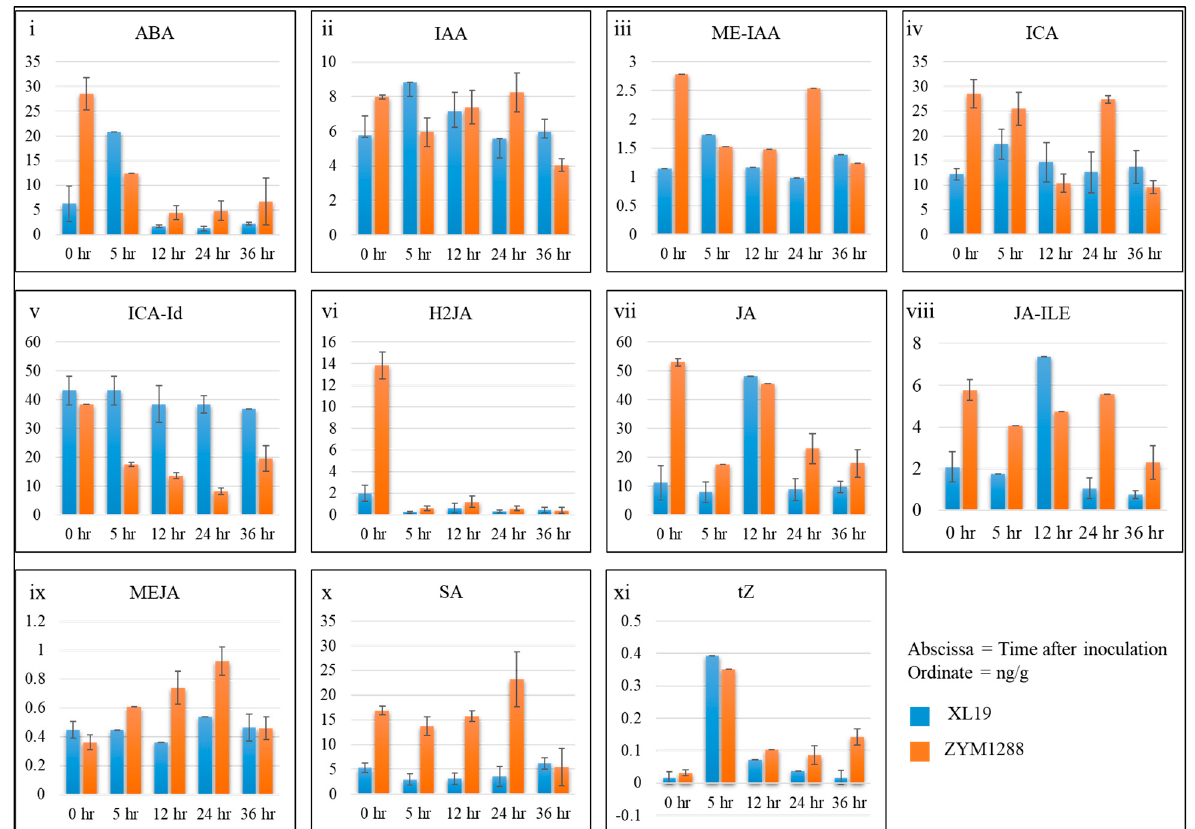
Figure 2. Phytohormonal concentrations in XL19 and ZYM1288 after 0 (CK), 5, 12, 24, and 36 hpi; ( i ) abscisic acid (ABA), ( ii ) indole 3-acetic acid (IAA), ( iii ) methylindole-3-acetic acid (ME-IAA), ( iv ) indole-3-carboxylic acid (ICA), ( v ) Indole-3-carboxaldehyde (ICAId), ( vi ) dihydrojasmonic acid (H2JA), ( vii ) Jasmonic acid (JA), ( viii ) (±)-Jasmonic acid-isoleucine (JA-ILE), ( ix ) methyl Jasmonate (MEJA), ( x ) Salicylic acid (SA), and ( xi ) trans-zeatin (tZ). The error bars represent standard deviation.